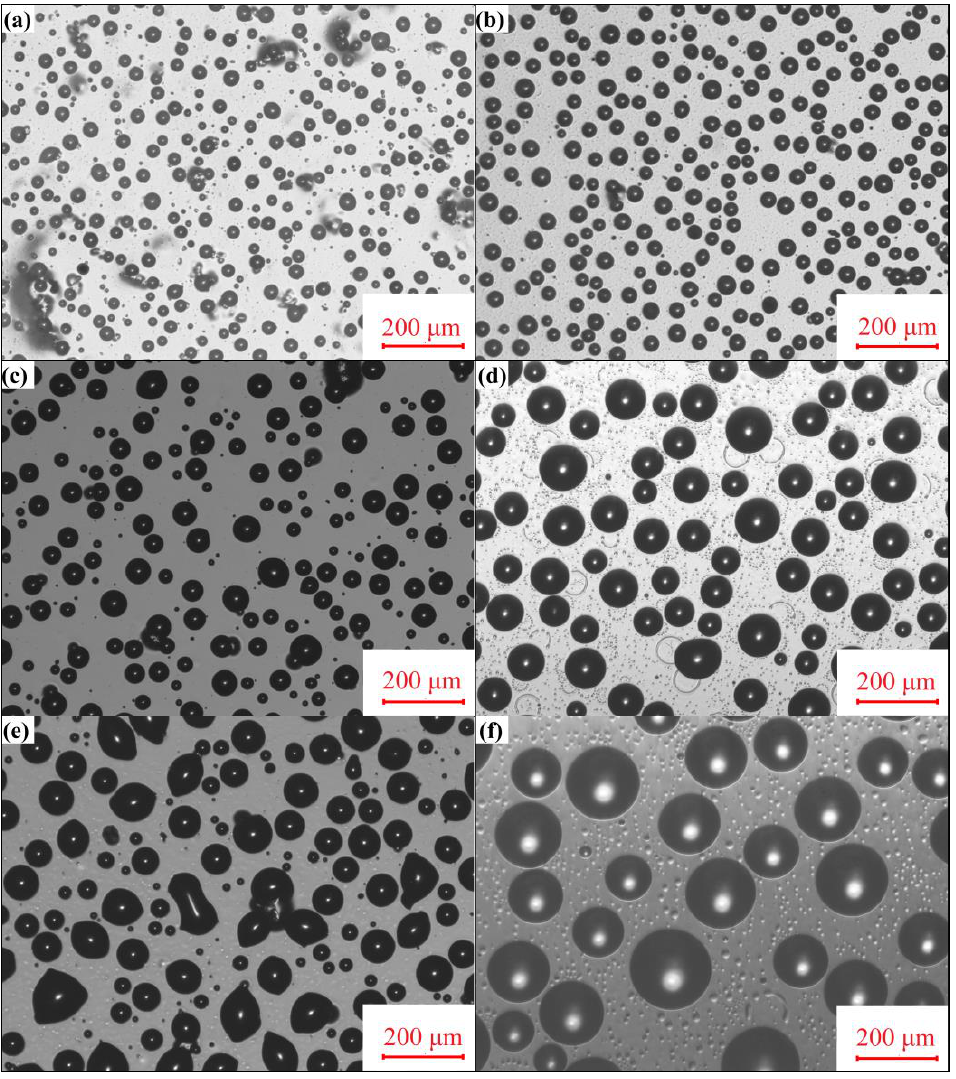
Figure 7. The leaching behavior of PSO on the surface after 30 days: ( a ) P 0 ; ( b ) P 4 ; ( c ) P 8 ; ( d ) P 12 ; ( e ) P 16 ; and ( f ) P 20 .